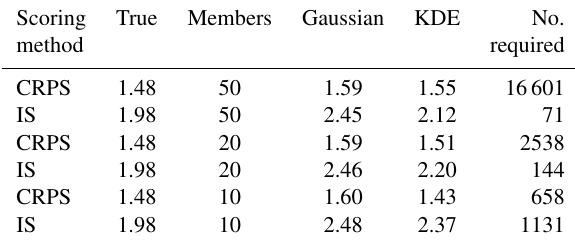
Table 1. The mean score of postprocessed forecast distributions drawn with varying ensemble sizes. Rows indicate the scoring method and ensemble size, while columns indicate the forecast dis- tribution used. The “True” column refers to the perfect score for each metric, where this is determined by evaluating on the true dis- tribution (not the drawn ensembles). The “No. required” column in- dicates how many 100-set forecasts are required before the sample mean Gaussian and KDE scores are distinct at the 95% confidence level for that particular skill score metric. Explicitly this is testing the variance of the mean of 100-set forecasts, where each set has the row’s listed number of ensemble